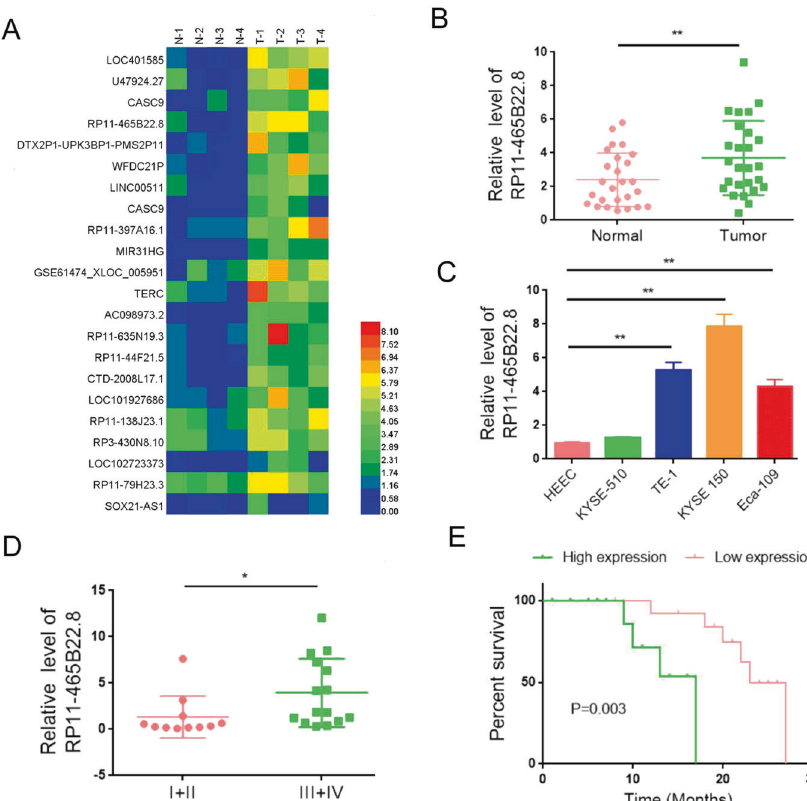
Fig. 1 LncRNA RP11-465B22.8 is upregulated in EC tissues and cells. A Heatmap representing the top differently expressed lncRNAs in EC tissues ( n = 4). Green shows high expression and blue shows low expression. B qRT-PCR analysis of the expression of lncRNA RP11-465B22.8 in EC tissues. C qRT-PCR analysis of the expression of lncRNA RP11-465B22.8 in EC cells. D qRT-PCR analysis of lncRNA RP11-465B22.8 in EC tumors at different states. E High lncRNA RP11-465B22.8 expression predicted poor survival of EC patients. * P < 0.05, ** P < 0.01.